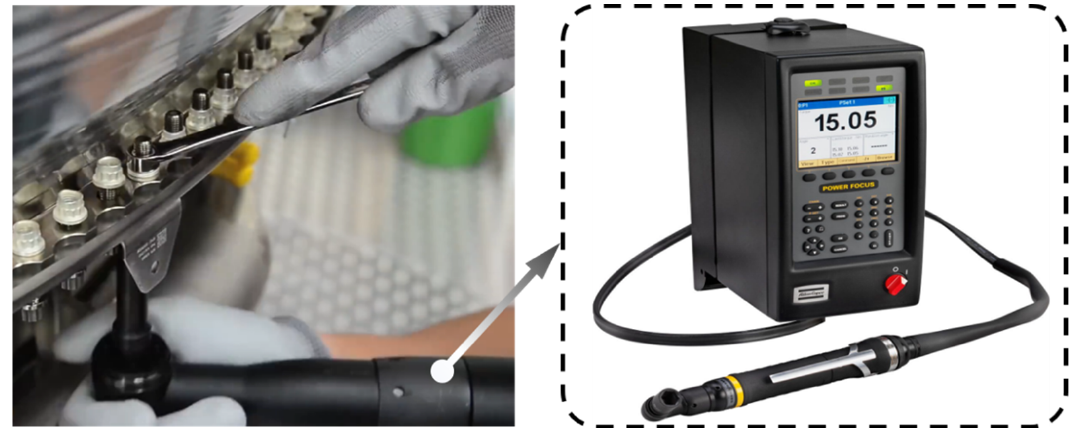
Figure 19. Schematic diagram of an electric wrench.